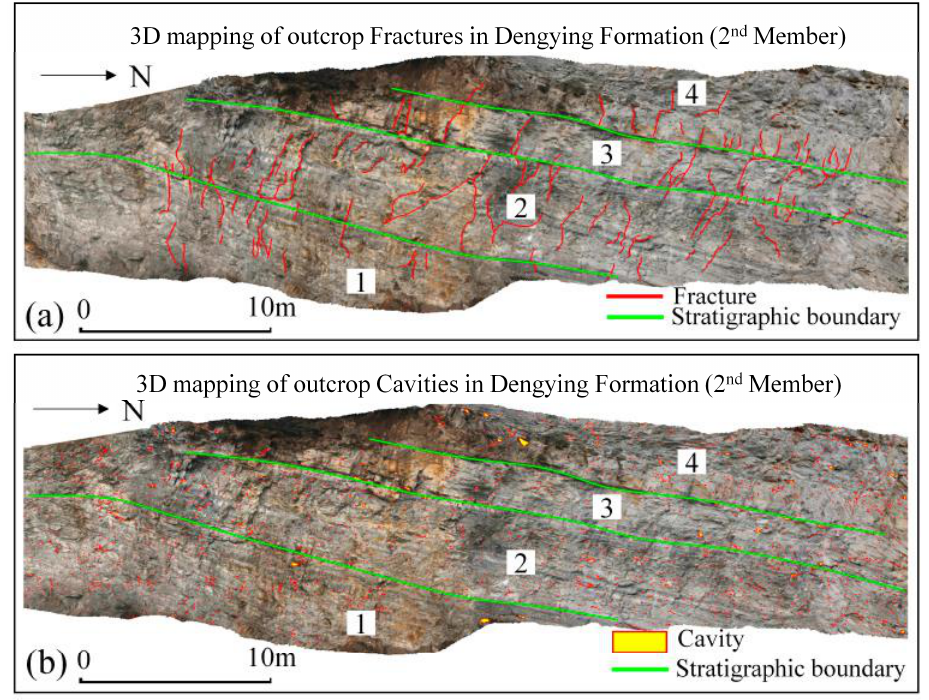
Figure 9. 3D visualization of fractures and cavities of the Dengying Formation (second member). ( a ) 3D visualization of fractures. ( b ) 3D visualization of cavities.